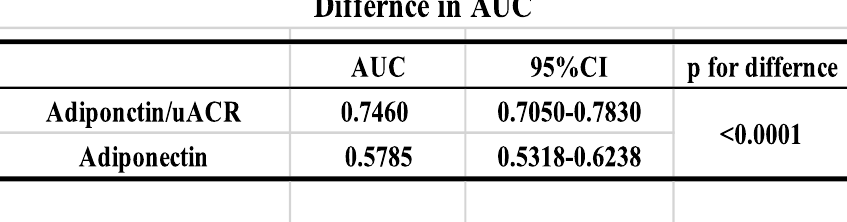
Figure 2. ROC curves of serum adiponectin and serum adiponectin-to-uACR ratio to predict T2D. Red line: serum adiponectin concentration; green line: uACR ratio. The differences in the AUCs between the analyses are shown below the plot. ROC, receiver operating characteristic; T2D, type 2 diabetes; AUC, area under the ROC curve; uACR, urinary albumin/creatinine